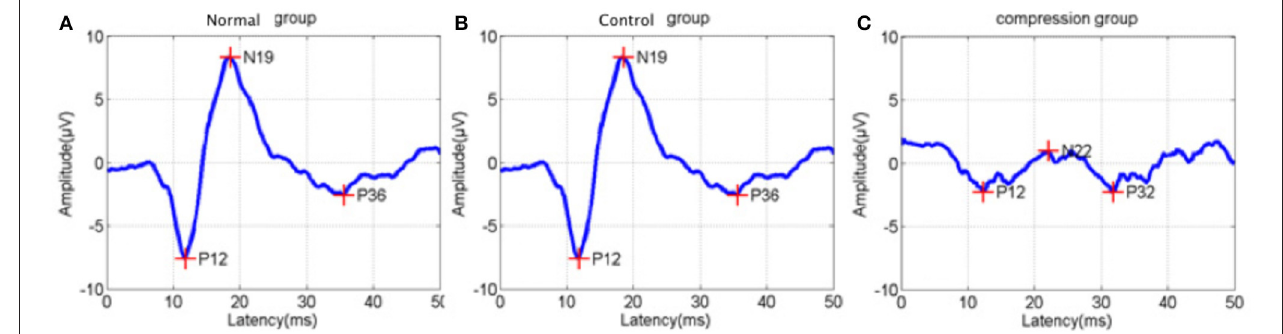
FIGURE 3 | Sample of latency prolongation and amplitude reduction of somatosensory evoked potentials (SEP) from normal status (A) , control status (B) , and compression status (C) .